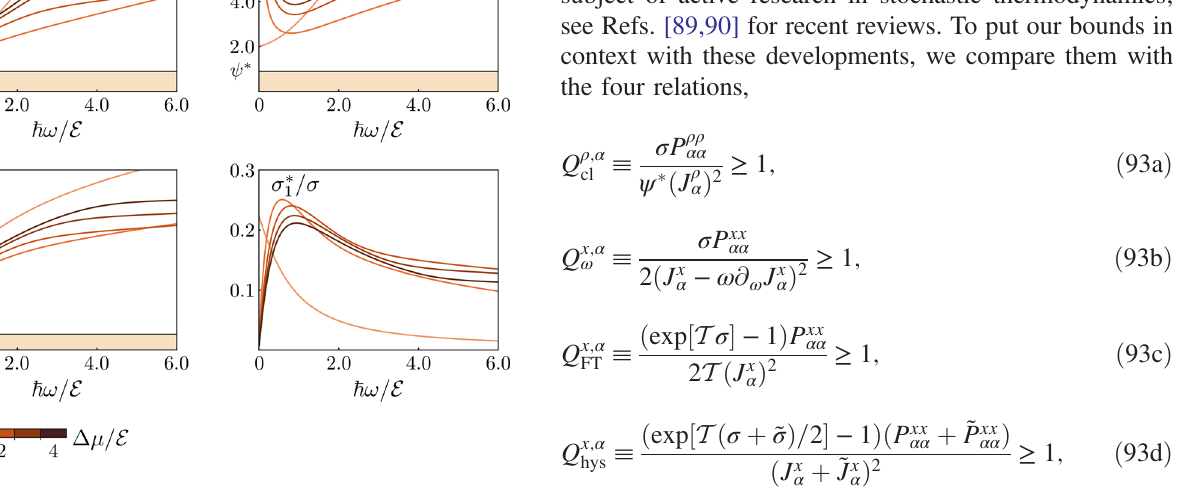
FIG. 5. Quantum generator far from equilibrium. The first three plots from top left to bottom left show the quantities (92a) – (92c) as functions of the driving frequency for different biases. Here, E ≡ ℏ 2 = 2 Ml 2 denotes the natural energy scale of the device with M being the carrier mass and l the circumference of the loop, cf. Fig. 2. The shaded areas indicate the bounds (78a), (87), and (89), respectively, for Q ð 1 Þ , Q ð 2 Þ , Q ð 3 Þ . The last plot shows the lower bound on entropy production (92d) in units of the actual dissipation rate σ . For all plots, we have set μ ¼ 0 , μ 1 = E ¼ Δ μ = E ¼ 0 ; 1 ; … ; 4 and T= E ¼ 1 = 2 .